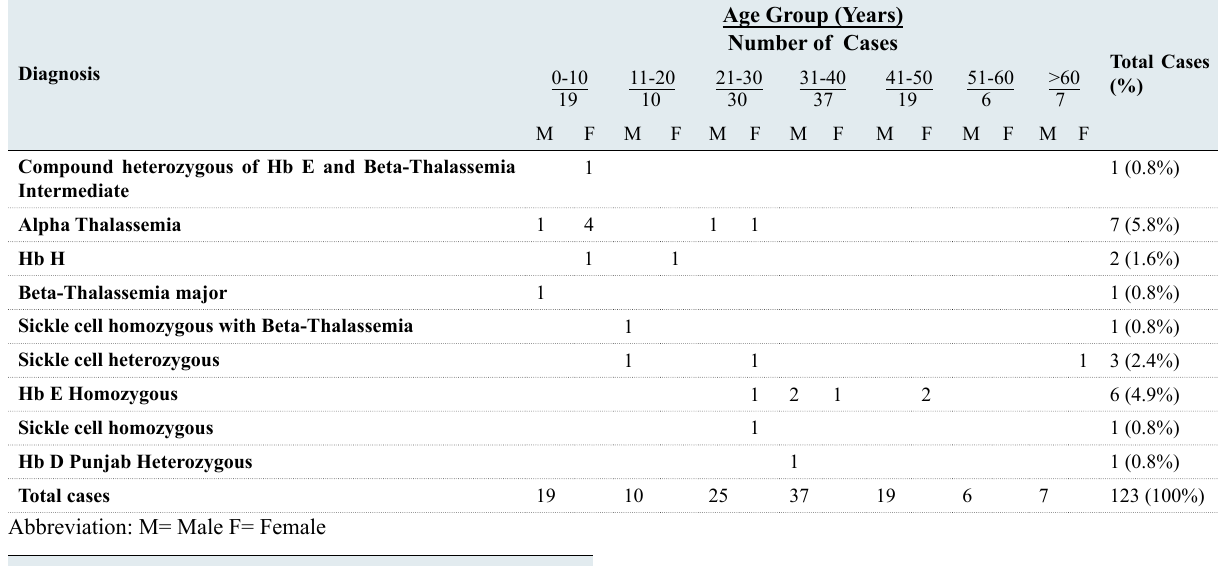
Table 1: Prevalence of hemoglobinopathies in various age groups